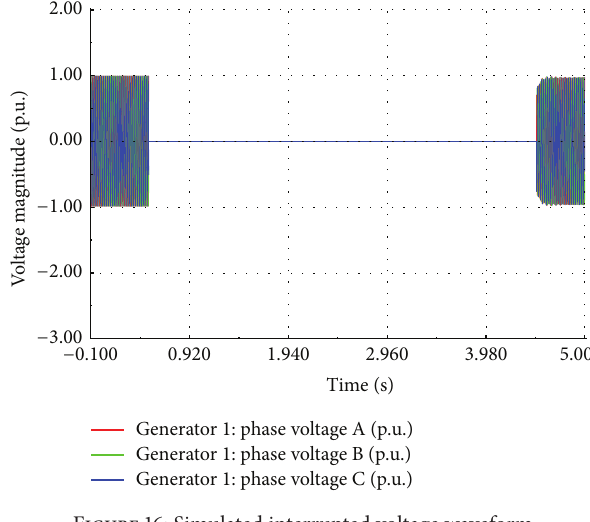
Figure 16: Simulated interrupted voltage waveform.